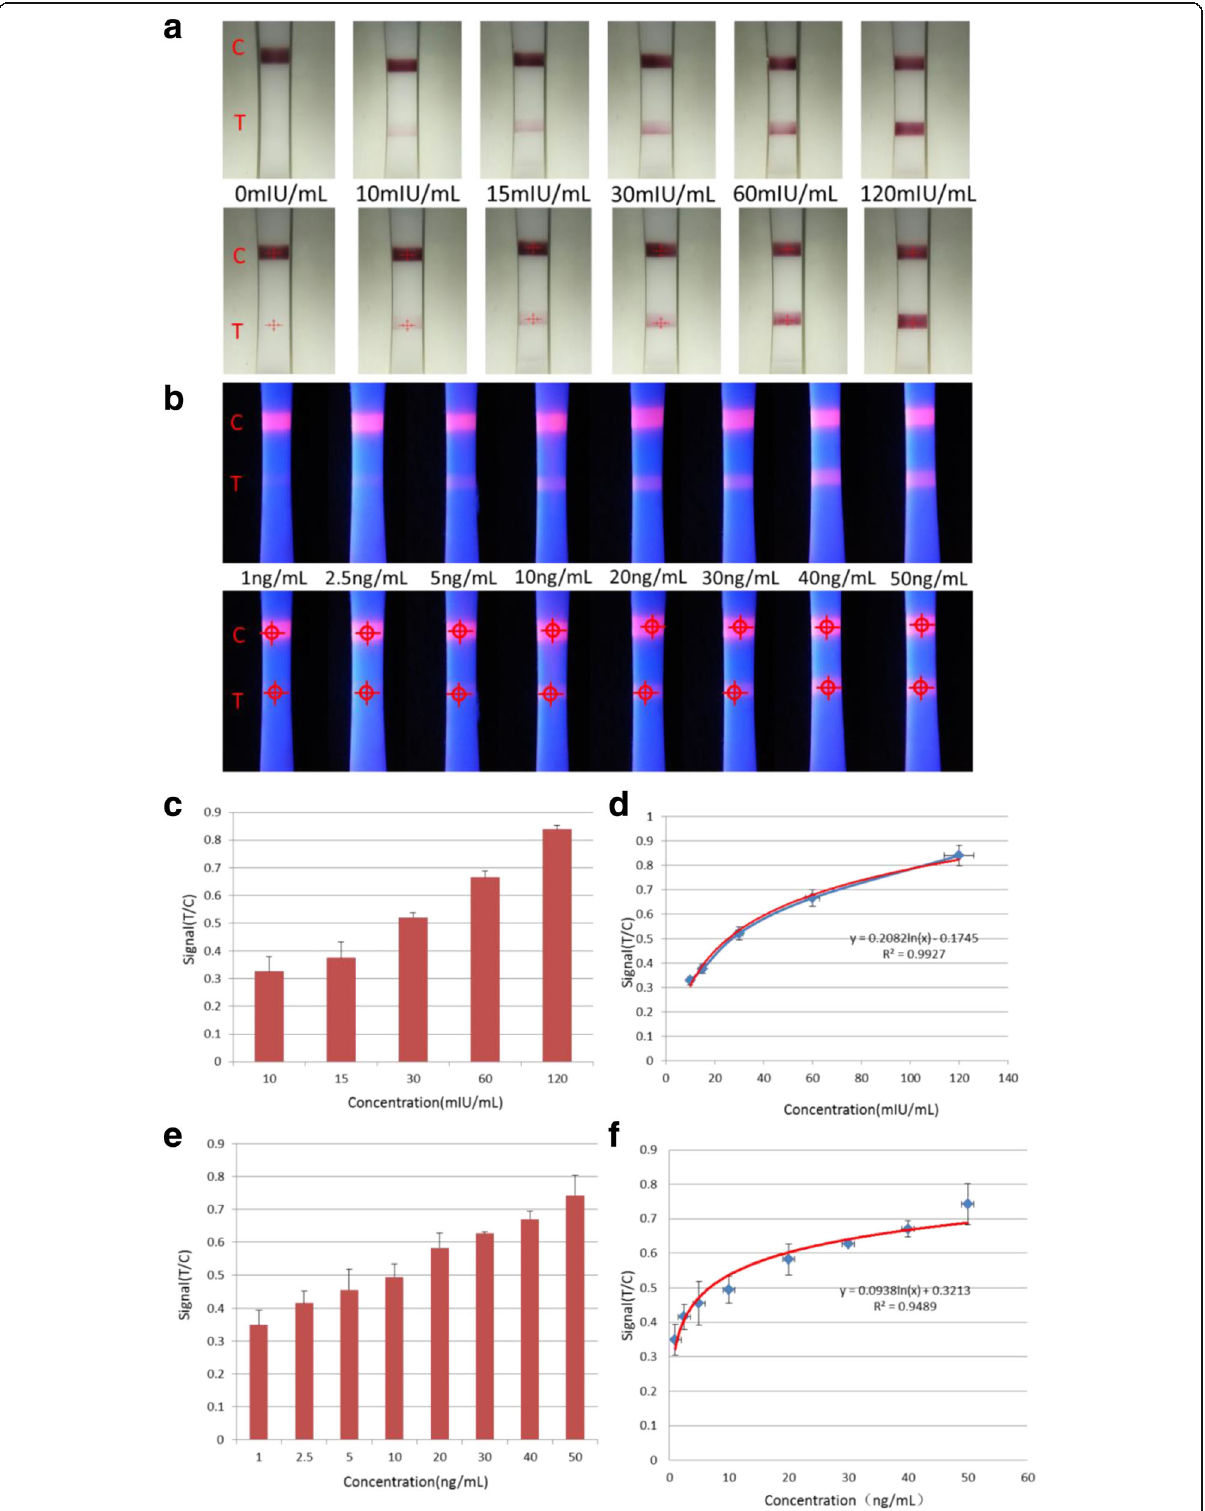
Fig. 7 a Different concentrations of the colloidal gold strips for HCG. b Different concentration of the fluorescence strips for CEA. c Colloidal gold strip signal intensity. d Standard curve for quantitative detection of HCG. e Fluorescent strip signal intensity. f Standard curve for quantitative detection of